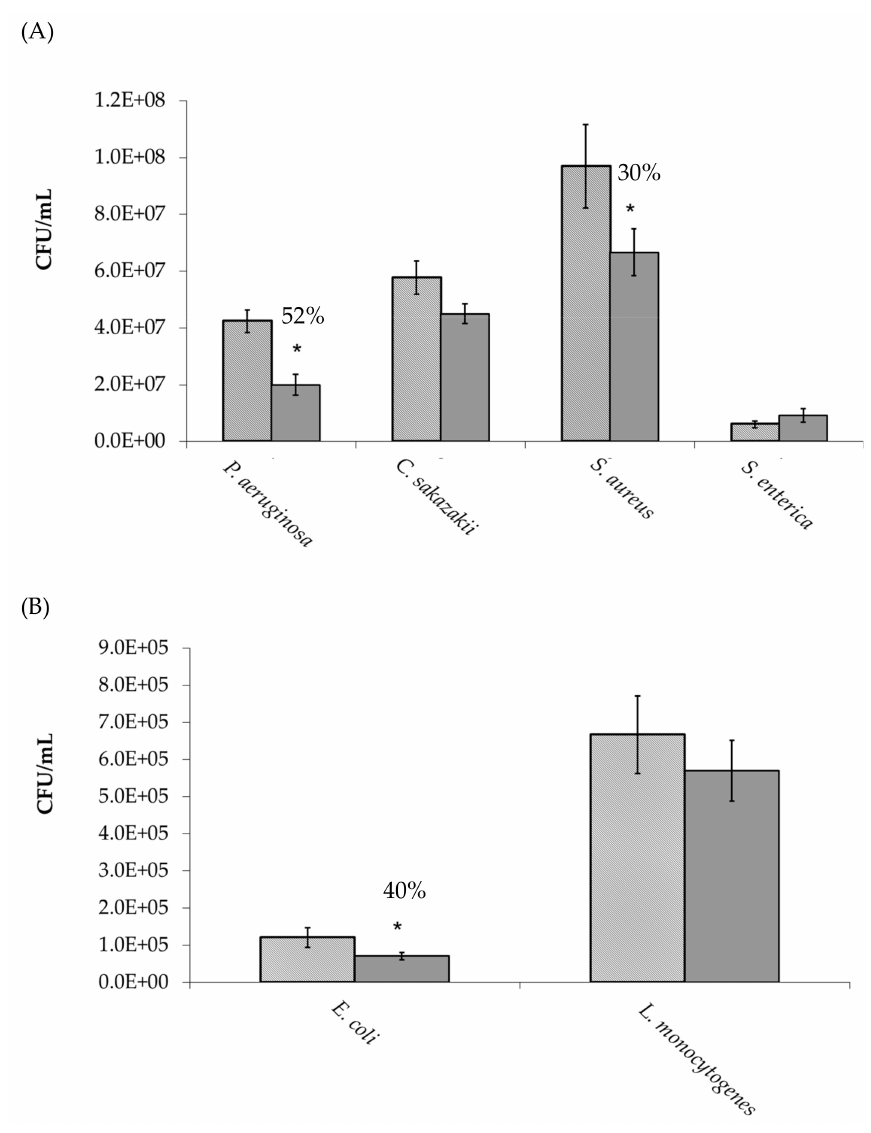
Figure 3. Adhesion of bacteria to HT-29 cells in the absence and presence of manuka honey oligosaccharides. * p ≤ 0.05 was considered